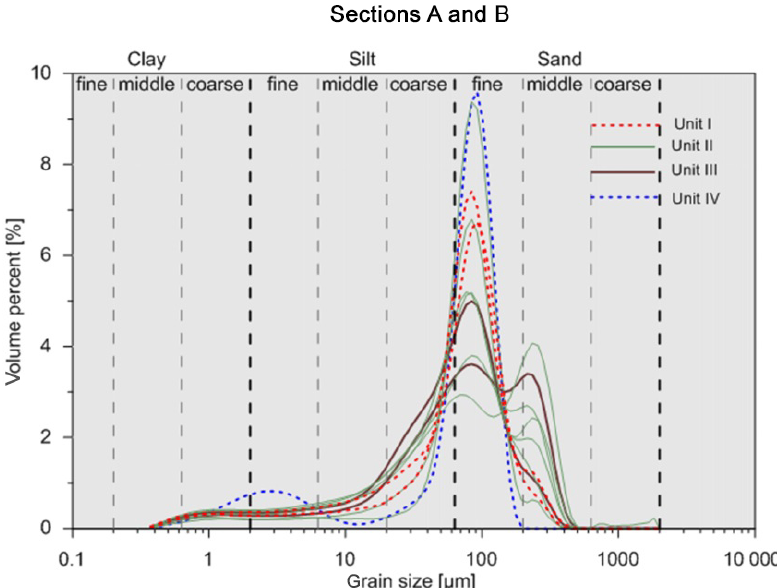
Figure 10. Grain size distribution plot for sections A and B of the Batagay permafrost outcrop.